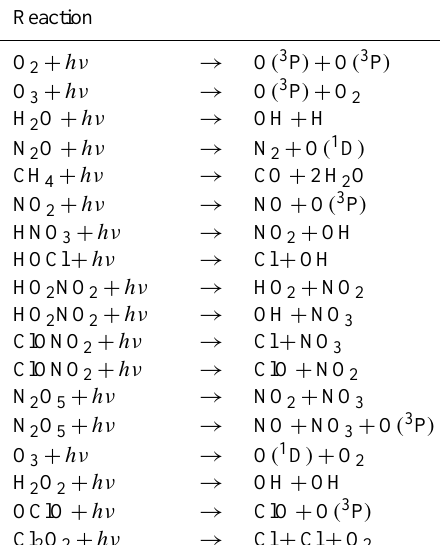
Table 2. List of photolysis